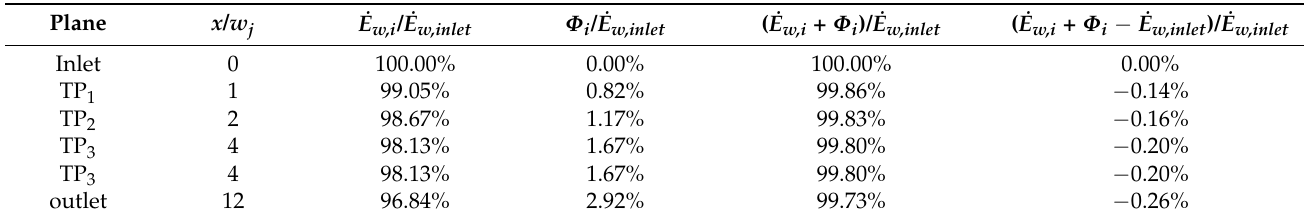
Table 2. Power terms at various locations of TPs in the simulation of a